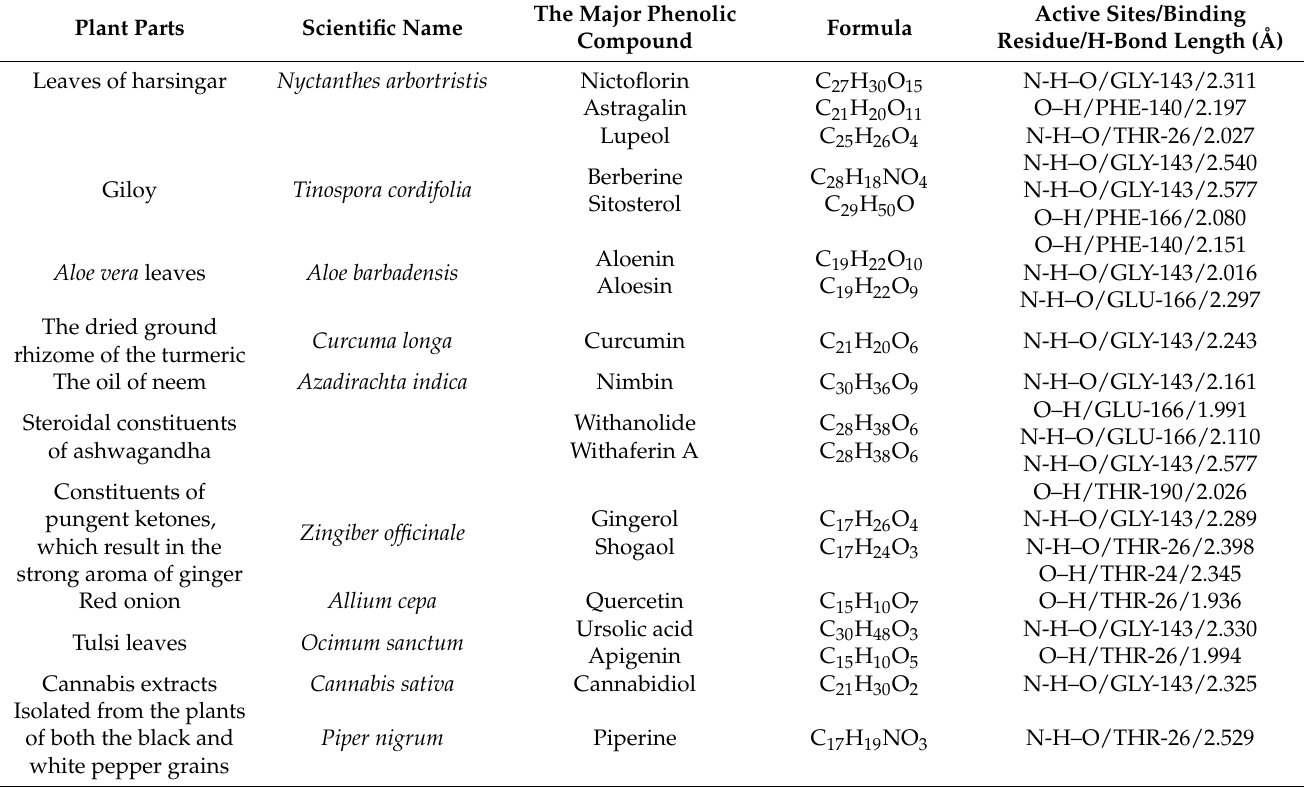
Table 5. In silico analysis of phenolic compounds extracted form medicinal